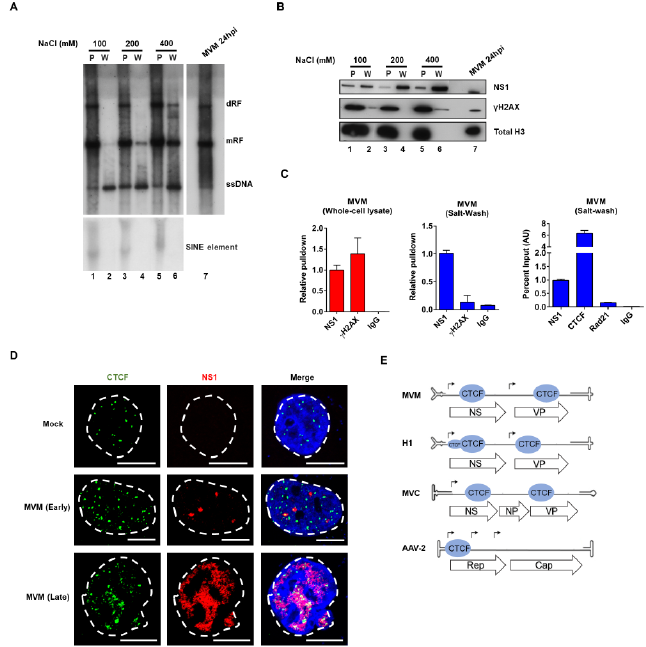
Figure 1. CTCF is associated with the viral genome and localizes to MVM replication compartments. ( A ) Murine A9 cells were parasynchronized by isoleucine deprivation and infected with MVMp at an MOI of 10 at the time of release into complete medium. At 24 hpi, viral nucleoprotein complexes were extracted from infected cells with various NaCl concentrations, and both the chromatin pellet (P) and the salt-wash extracts (W) were subsequently analyzed by Southern blotting as described in Materials and Methods. DNA extracted directly from infected cells served as a positive control (lane 7). The blot was hybridized with a radiolabeled MVM whole genome probe (top panel) and replicative intermediates of single-stranded DNA, ssDNA; monomer, mRF; and dimer, dRF; are indicated to the right. The blot was also hybridized with a genomic DNA probe against the SINE element (bottom panel). ( B ) Salt wash extracts and chromatin pellet described in ( A ) were assayed by Western blotting using antibodies directed against the indicated proteins. Whole-cell lysates of MVM-infected parasynchronized murine A9 cells were also analyzed by Western blotting with the indicated antibodies and served as a positive control (lane 7). ( C ) Murine A9 cells were parasynchronized by isoleucine deprivation and infected with MVMp at an MOI of 10 at the time of release into complete medium. At 16 hpi, cells were processed, as described in Materials and Methods for whole-cell lysate ChIP (left panel) or ChIP on salt wash extracts (middle and right panel) with the indicated antibodies. Samples were analyzed by qPCR as described in Materials and Methods. Data are presented as mean ± standard error of the means (SEM) of two individual experiments. Background binding levels were determined using mouse IgG pulldowns. ( D ) Representative confocal images of Mock versus MVM infected, non-synchronized human NB324K cells at 24 hpi, probing MVM-NS1 (red) and the host cellular factor CTCF (green). CTCF co-localized with NS1 in both early and late stage APAR bodies designated as previously described [12] (middle and bottom panel respectively). Blue corresponds to DAPI staining. Nuclear border is indicated by dashed white line. ( E ) Schematic representation of the protoparvoviruses MVM, MVC, H1, and the dependovirus AAV2 genome showing the positions of transcriptional promoters (solid black arrows), the major open reading frames that encode the viral non-structural and capsid proteins (arrowed boxes), and the relative positions of CTCF binding sites (blue oval